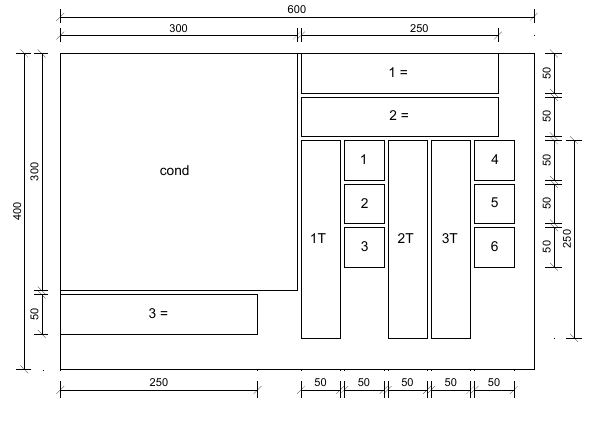
Figure 3. Cutting scheme of particleboards.